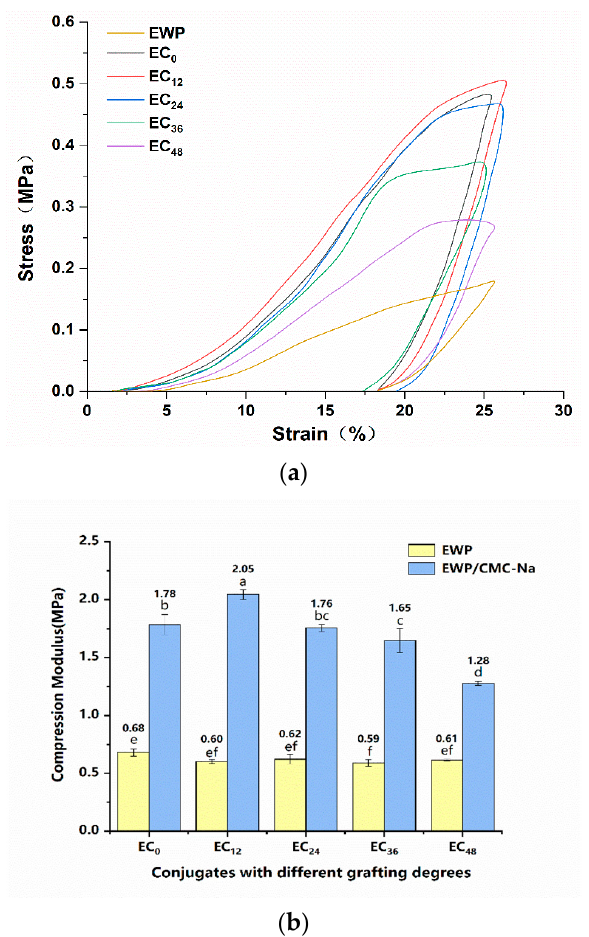
Figure 3. Mechanical properties of the aerogels in dry conditions: ( a ) stress − strain curves and ( b ) compressive strength.